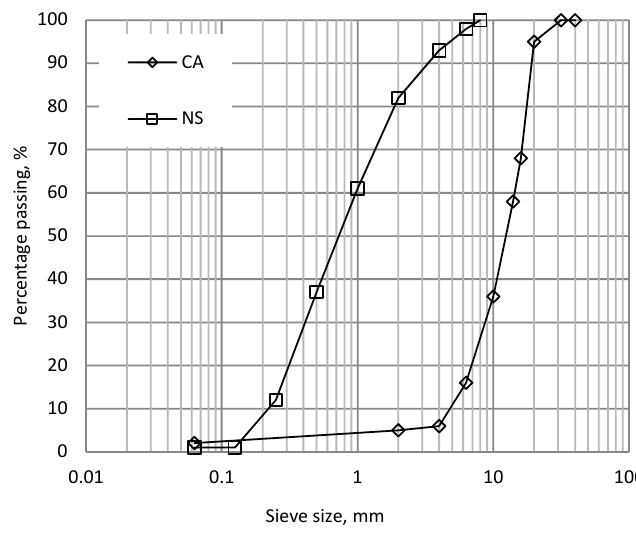
Figure 2. Coarse Aggregate and Natural Sand particle size distribution.